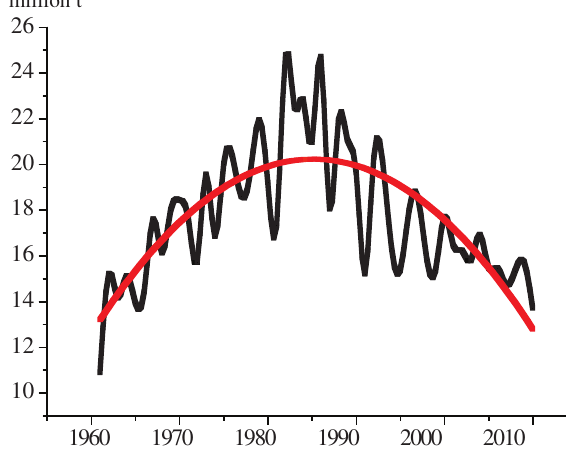
Fig. 2. Apple production in Europe